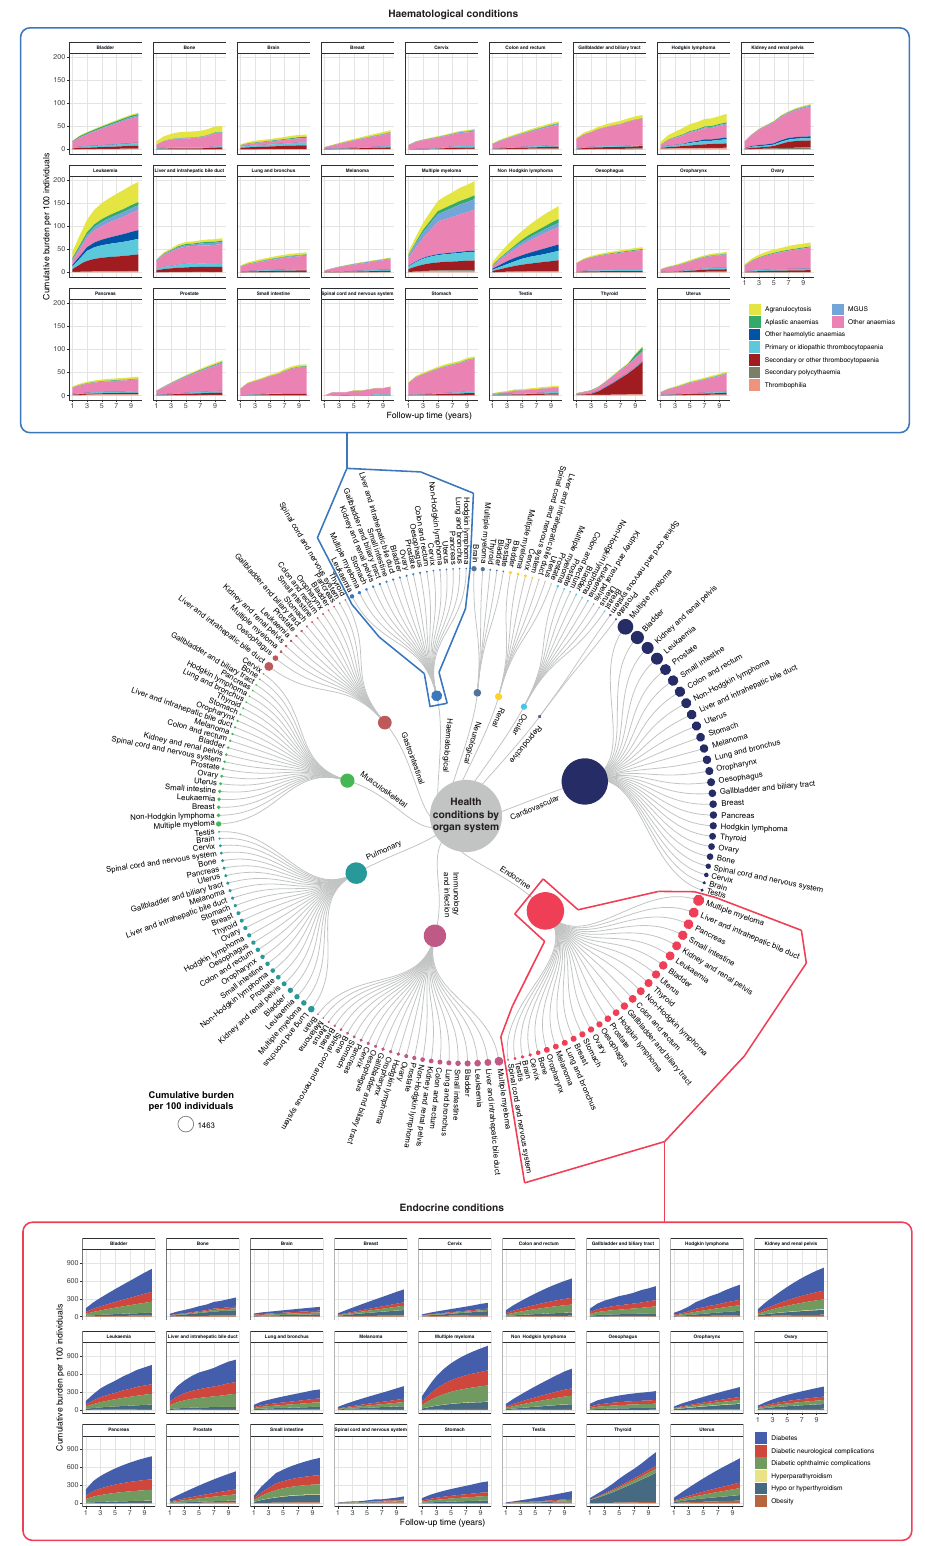
Fig.3|Cumulativeburdenofhealthconditionsamongcancersurvivorsacross organ systems. Cumulative burden per 100 individuals according to follow-up timeisshown.Circulardendrograminthecentredepictsthecumulativeburdenof health conditions at the organ system level at 5 years of follow-up. Within each organ system, cancer types are ranked from the highest to lowest burden. For example, when considering pulmonary conditions, patients who had lung cancer havethehighestdiseaseburden.Thecirculardendrogramonlydisplaysconditions